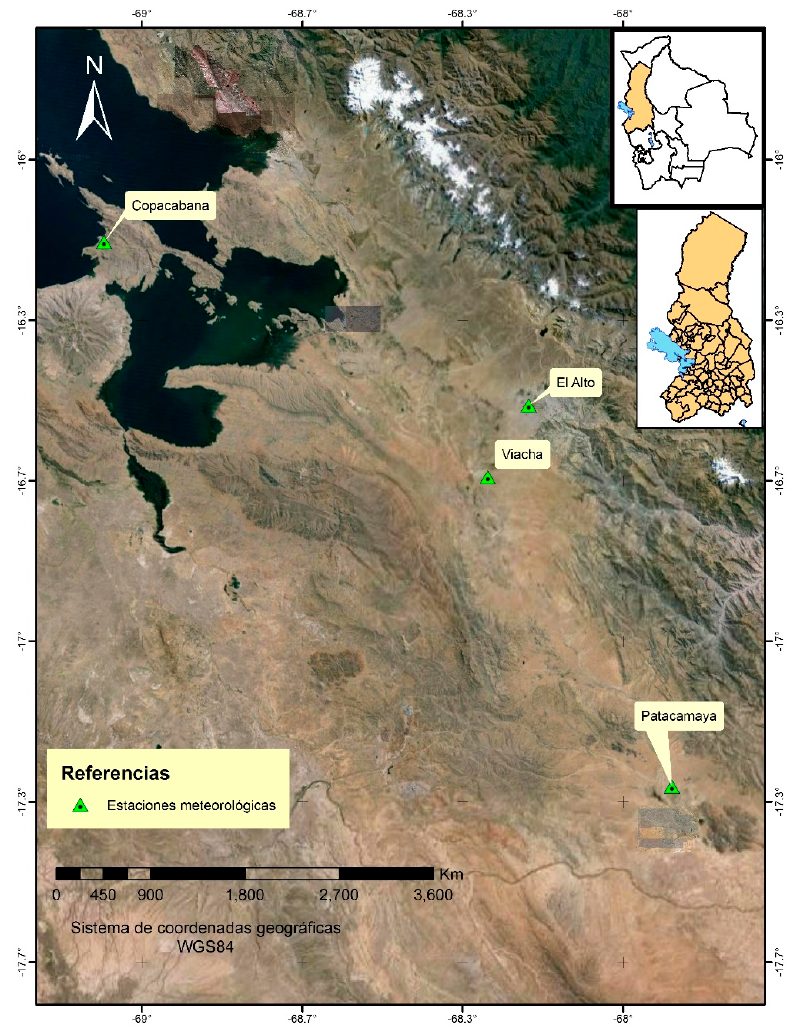
Figure 1. A map of the Bolivan Altiplano region and the four weather stations used here. The insets show the region studied compared to the entire country. The four weather stations are; (1) Copacabana; (2) El Alto; (3) Patacamaya; and (4)